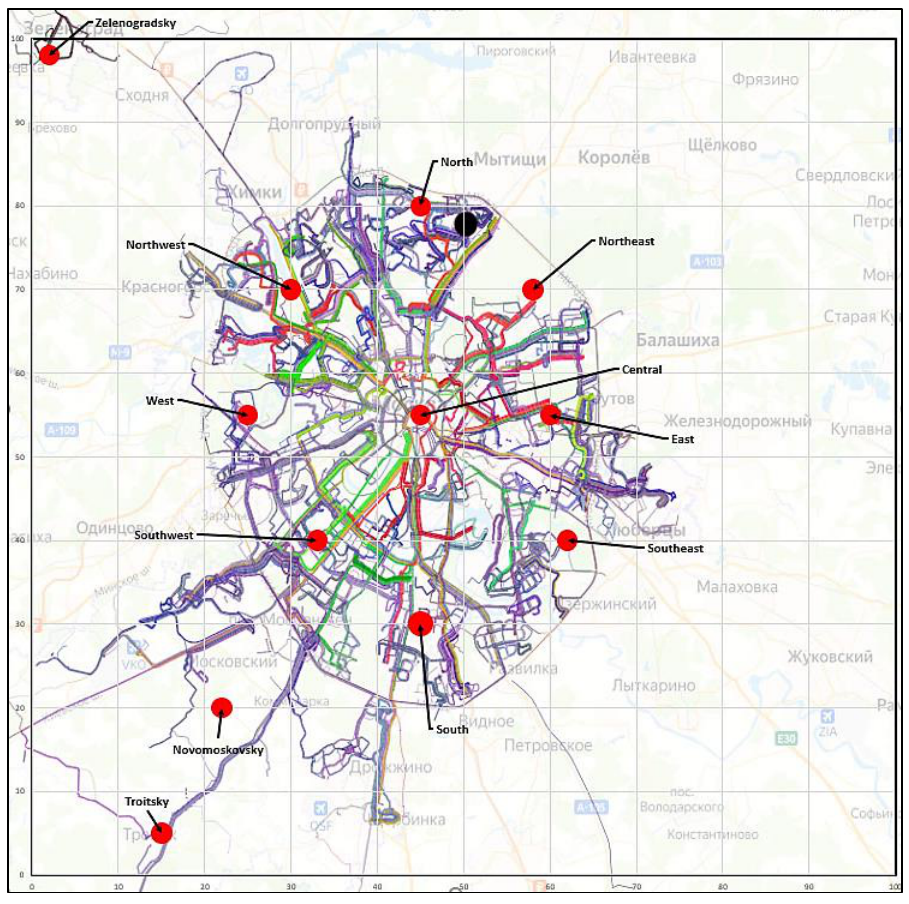
Figure 1. The structure of the transport system and the administrative districts of